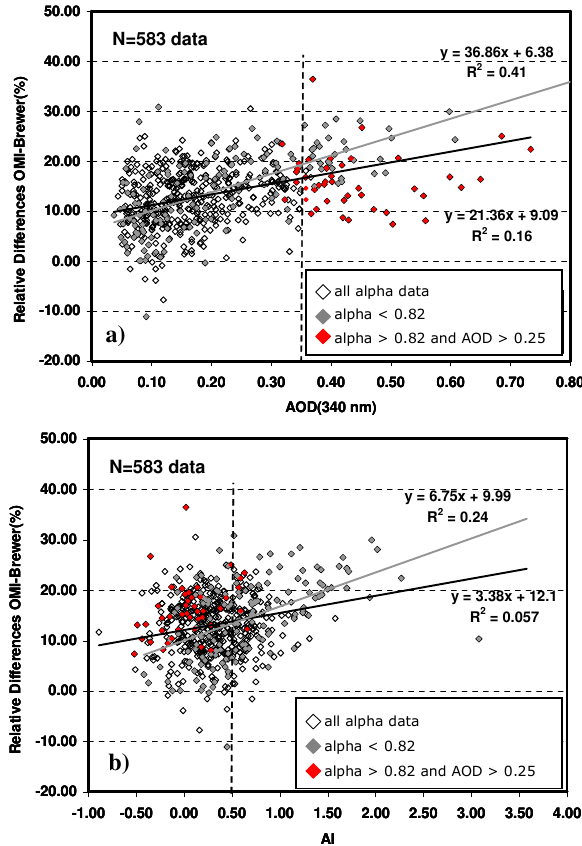
Fig. 3. (a) Dependence of the relative difference between OMI and Brewer UVER with respect to the aerosol optical depth (AOD) at 340nm for cloud-free conditions. The two fits are shown (b) OMI bias as function of AI index where different subsets of aerosols specified by alpha and AOD values are represented (see text). “all alpha data” set includes white, grey and red